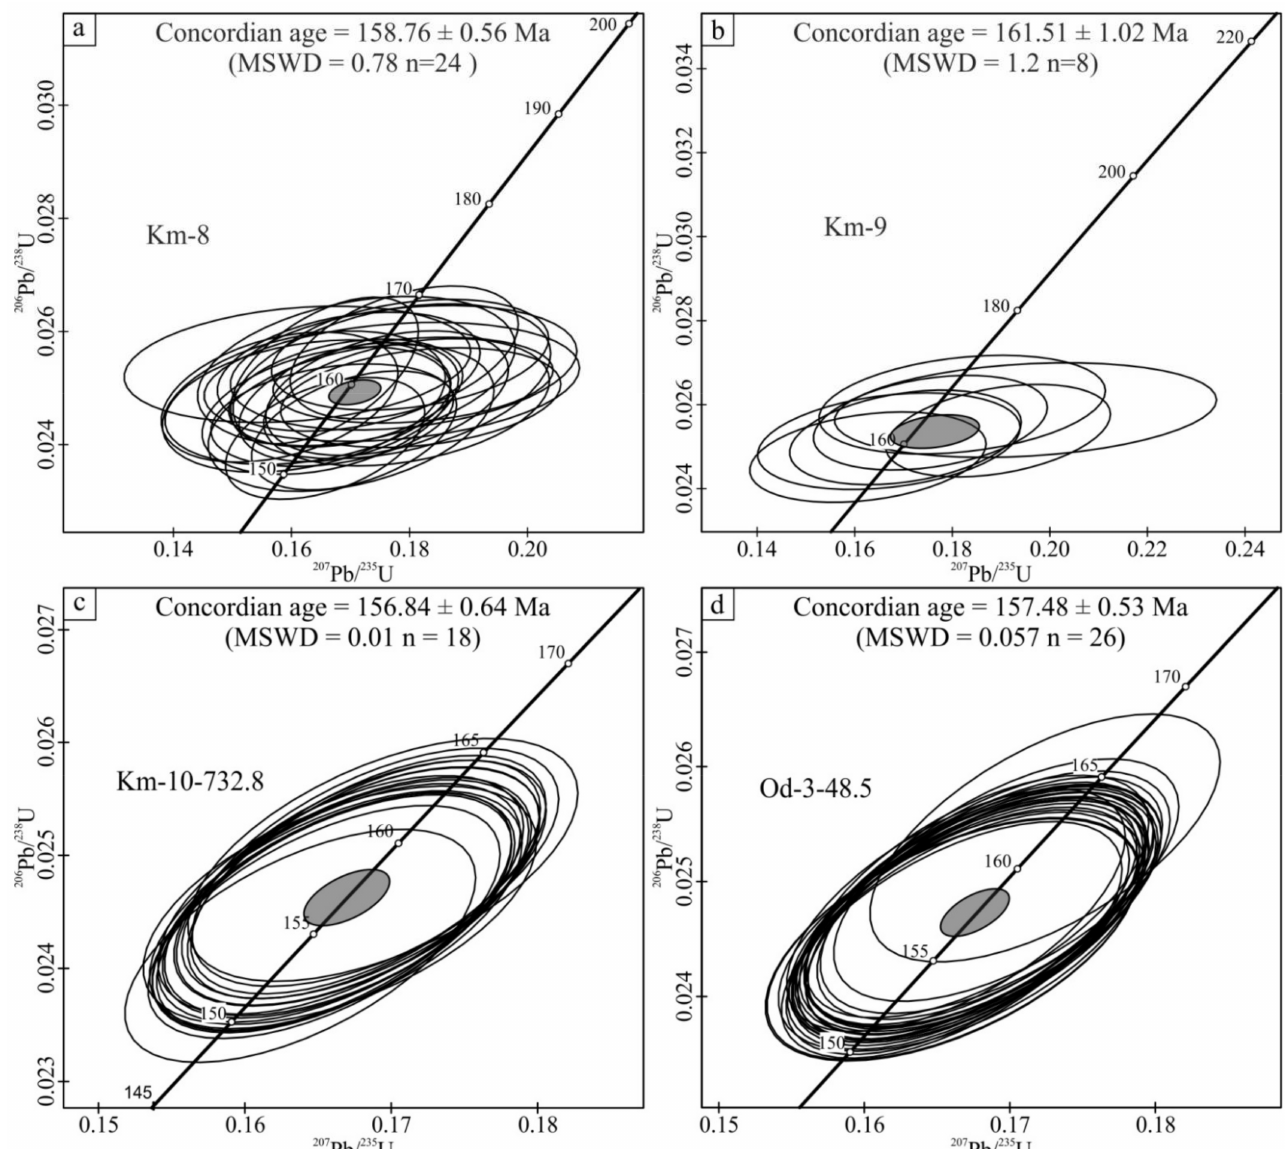
Figure 18. Concordia diagrams of LA-ICP-MS zircon U–Pb data for the magmatic rocks of the Kultuma deposit. ( a – c ) zircons from quartz monzodiorite-porphyries; ( d ) zircons from from